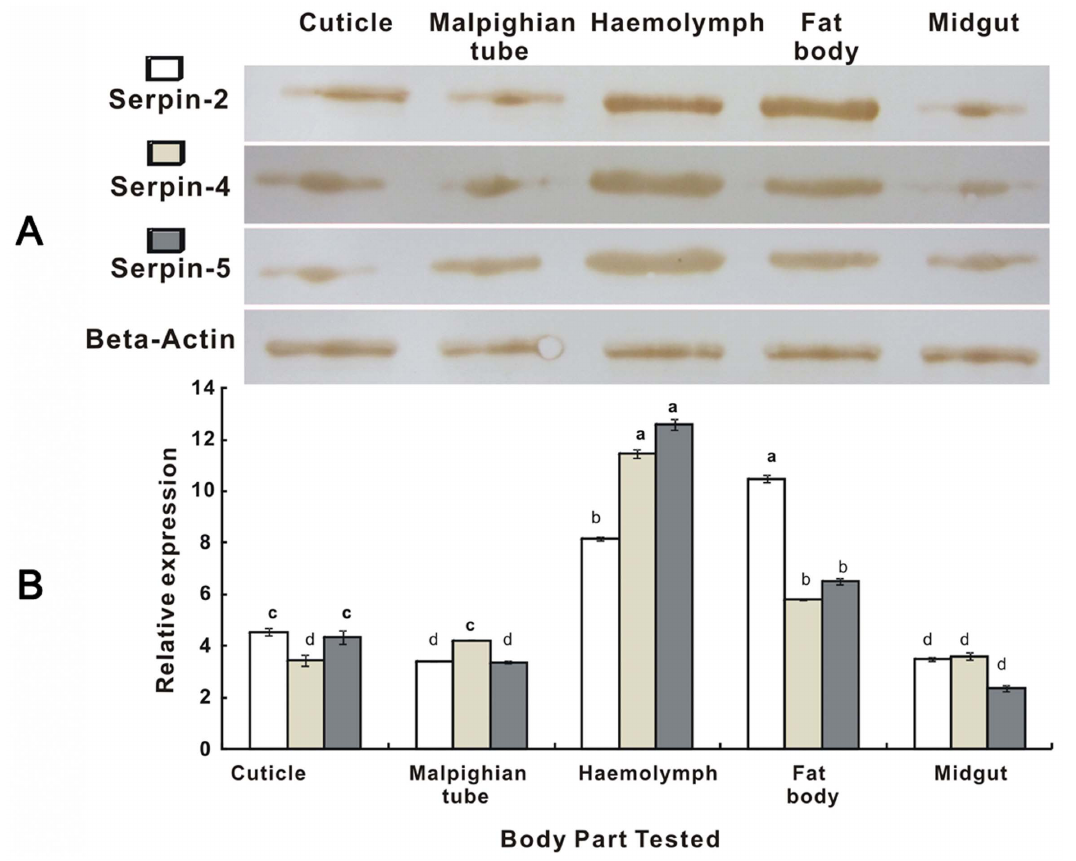
Figure 6. Expression of serpin-2, serpin-4 and serpin-5 in different tissues of Plutellaxylostella detected by Western Blot (A) and qRT- PCR (B). The mRNA and protein levels were normalized relative to the b -Actin. The different letters above the columns indicate significant differences in serpins genes expression during P. xylostella development ( P , 0.05). Each point represents mean value 6 S.E.M of three independent experiments with three individuals in each replicate. Western Blot analysis visualized by